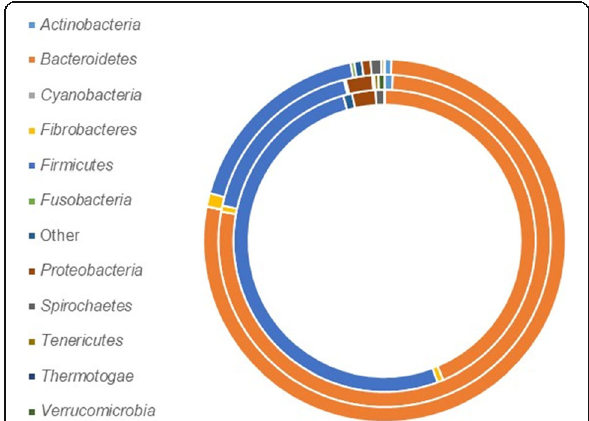
Fig. 2 Abundance (%) and diversity of genes encoding pectin methyl esterase (PME; PF01095)-domain containing proteins in a combined rumen metagenome and metatranscriptome dataset (outer circle; n = 2414), metagenome-assembled genomes (middle circle; n = 505) and Hungate1000 bacterial genomes (inner circle; n =